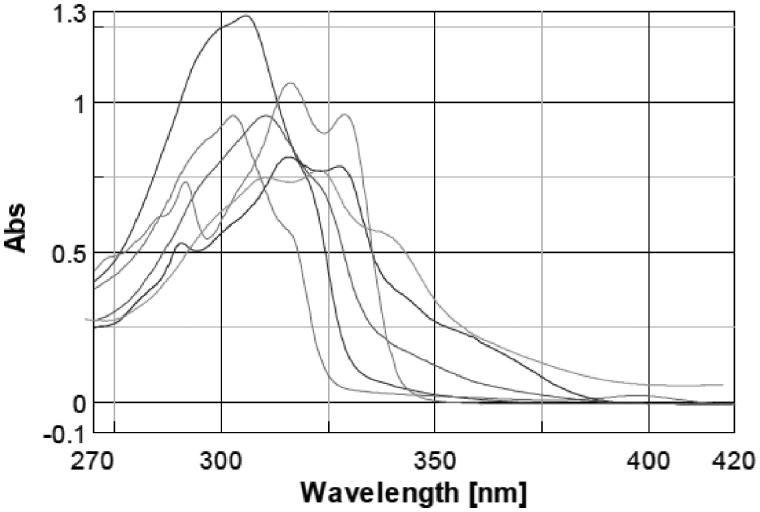
Comparison between spectra of PBSA and molecules without substituents on benzimidazole ring: 7, 8, 9, 10, 11.